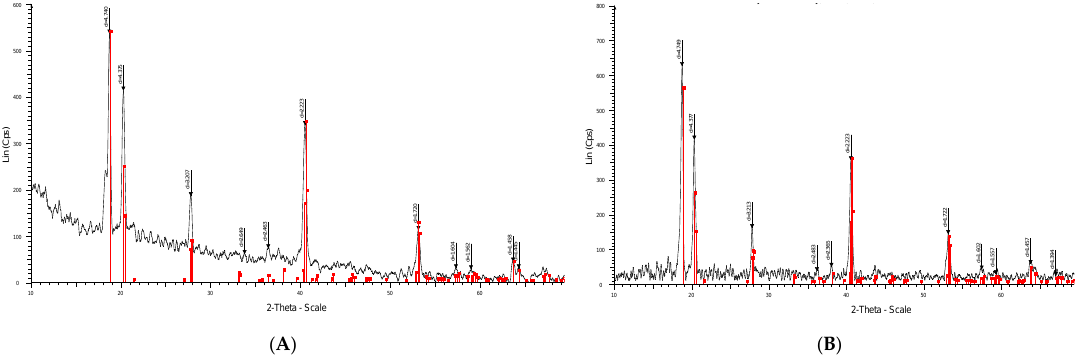
Figure 2. XRD patterns of synthesized α -Al(OH) 3 (bayerite) samples ( A ) and ( B ).